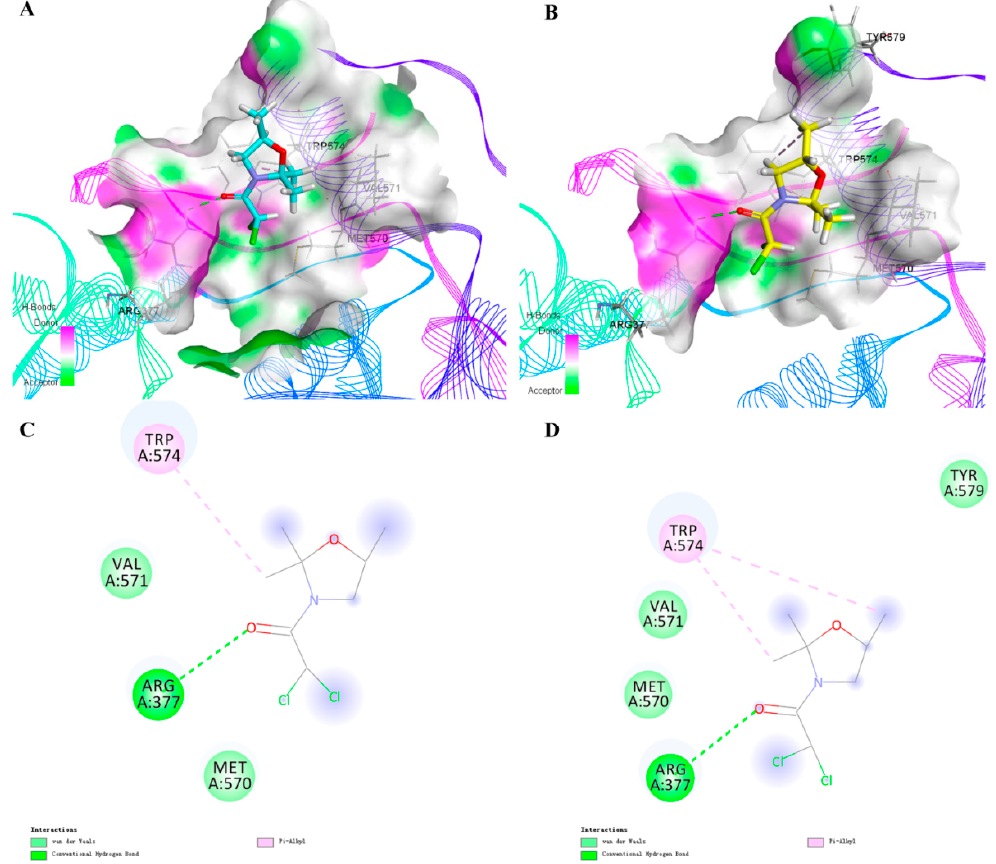
Figure 3. The docking model of ( A ) the R -isomer and ( B ) the S -isomer with the ALS active site, and the receptor–ligand interaction of ( C ) the R -isomer and ( D ) the S -isomer with the ALS active site.